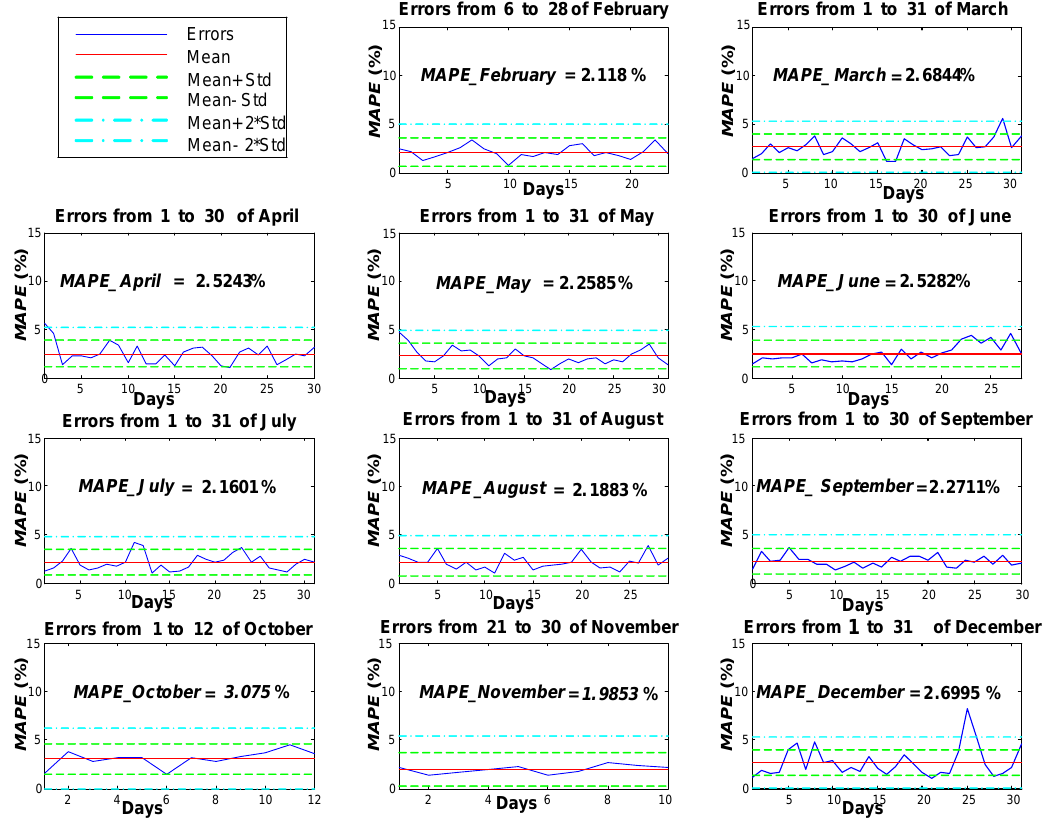
Figure 13. Errors per month. The y-axis represents the forecast error by Equation (1). The x-axis represents the days of the